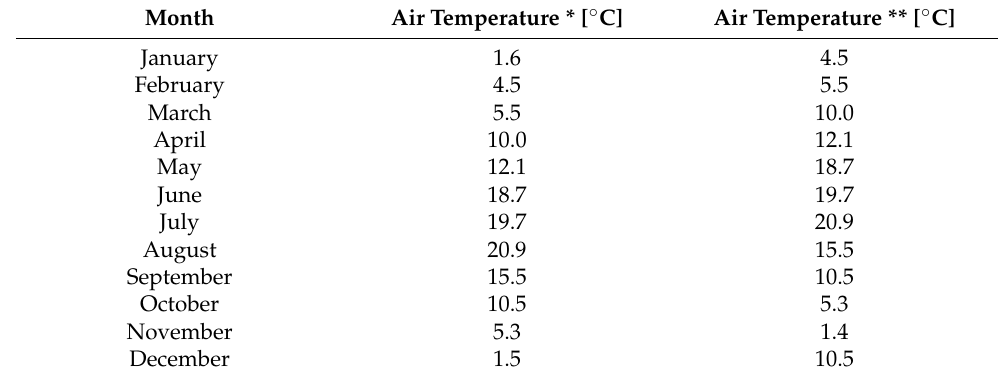
Table 2. AveragemonthlyatmosphericairtemperaturesinindividualmonthsintheKrakowagglomeration. Month Air Temperature * [ ◦ C] Air Temperature ** [ ◦ C]